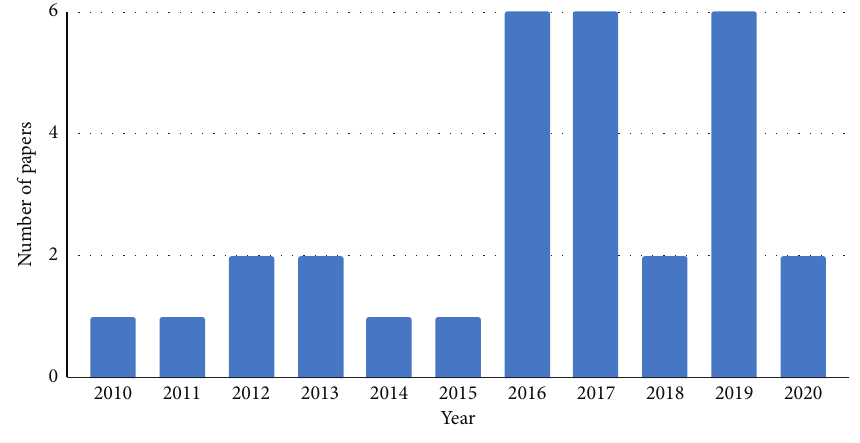
Figure 5: Number of papers reviewed per